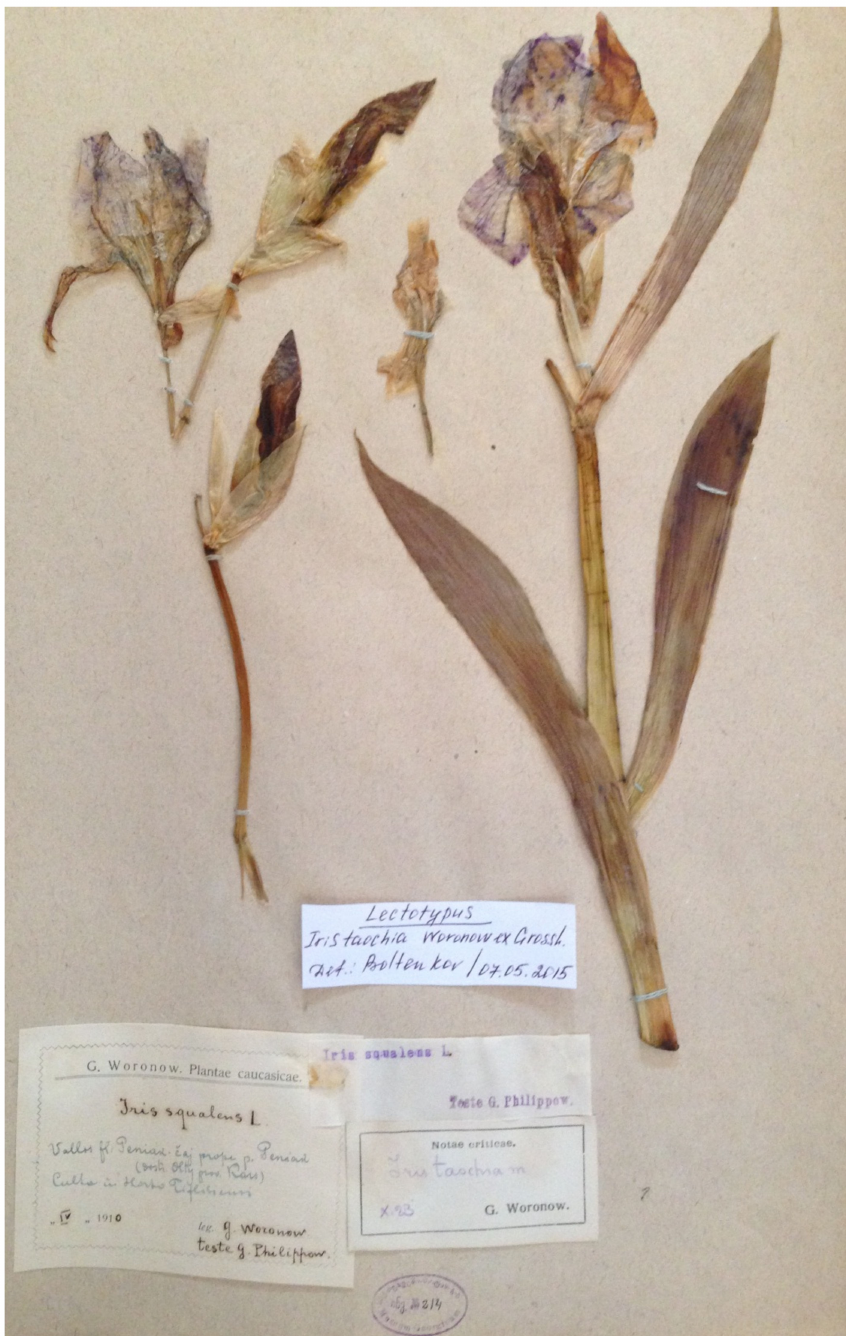
Figure 6. Lectotype of Iris taochia (TGM no. 214), by permission of the